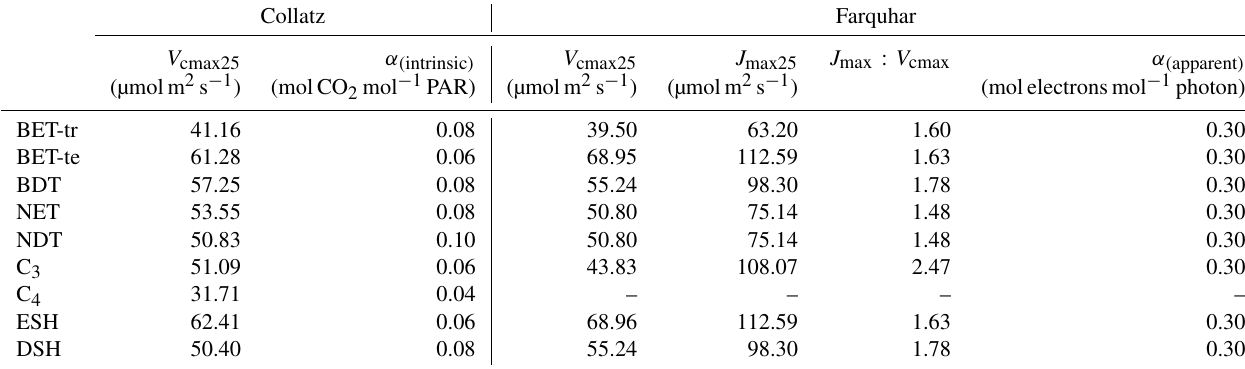
Table 2. PFT-specific parameters for the Collatz and Farquhar photosynthesis